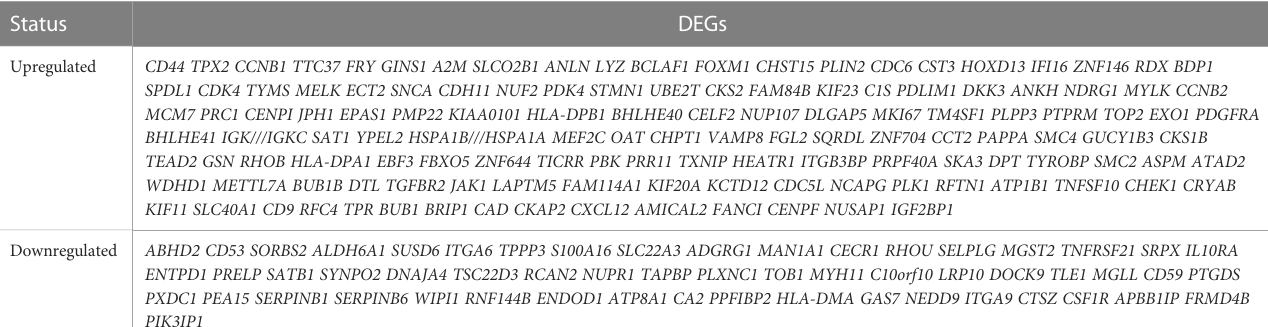
TABLE 1 Analyzation of the datasets identi fi ed 187 DEGs, including 131 upregulated and 56 downregulated genes, in tumor samples. Status DEGs Upregulated